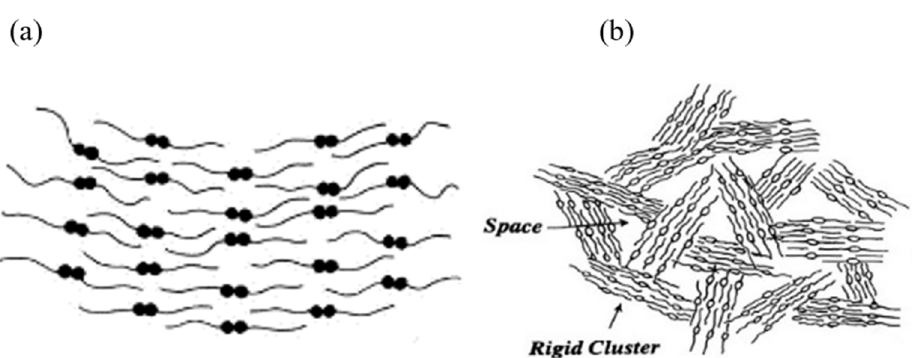
Figure 4. ( a ) α Linolenic acid dimers aggregate head‐to‐head to tail‐to‐tail quasi smectic liquid crys‐ tal and ( b ) microstructural morphology [25,26].